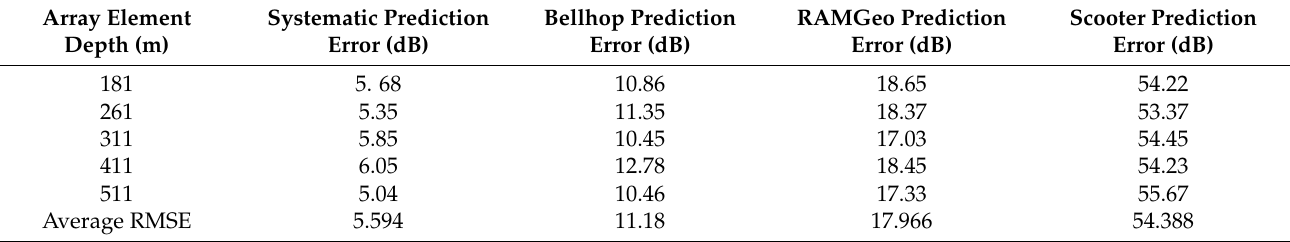
Table 8. RMSE error comparison (320–400 Hz).